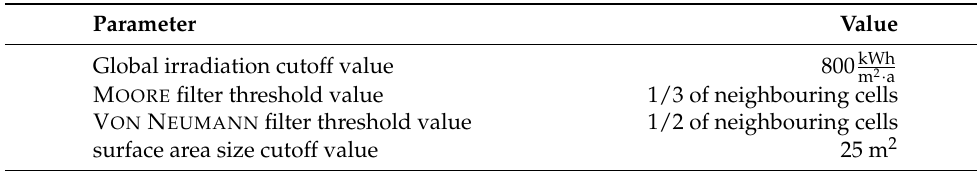
Table 1. Parameter settings chosen for the potential analysis in the city of Giessen and surrounding region.